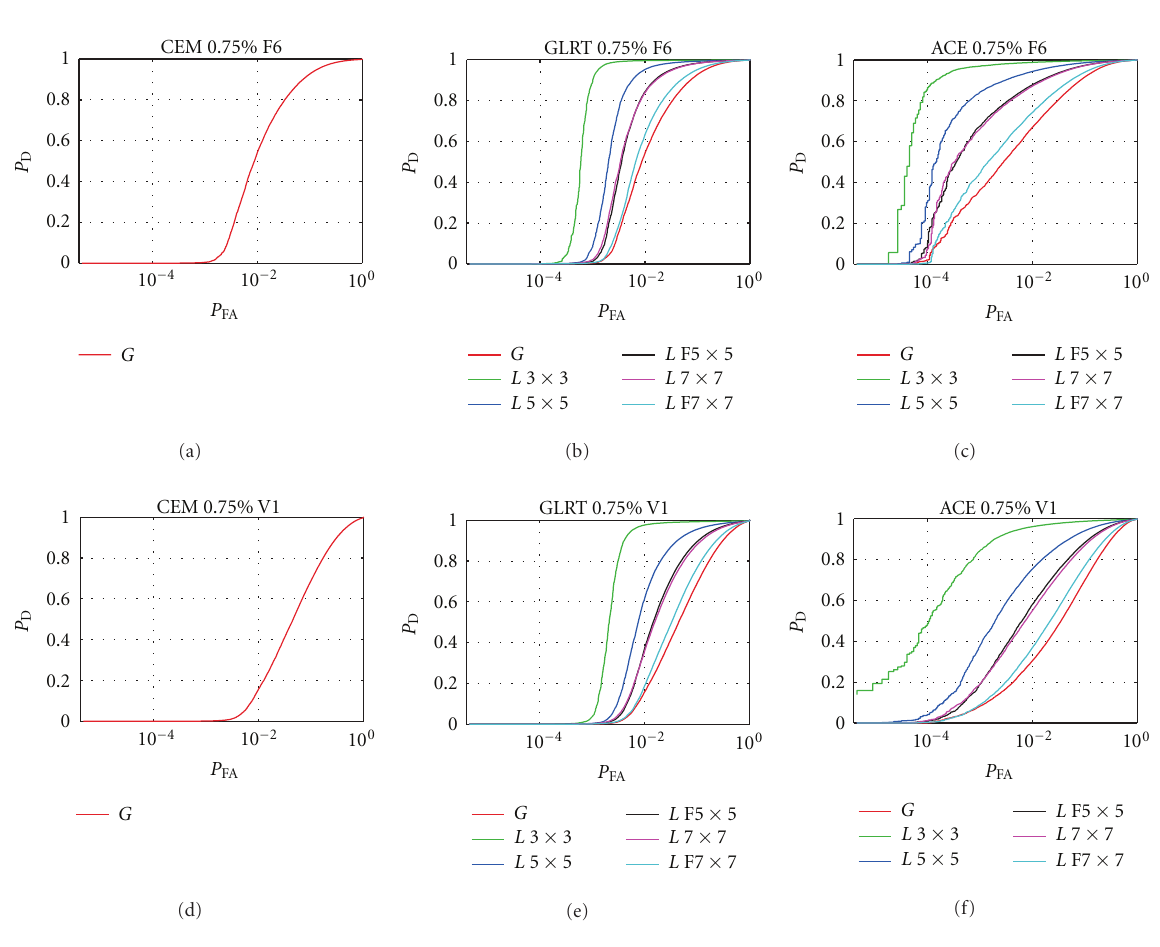
Figure 5: RBTA results for di ff erent size of local